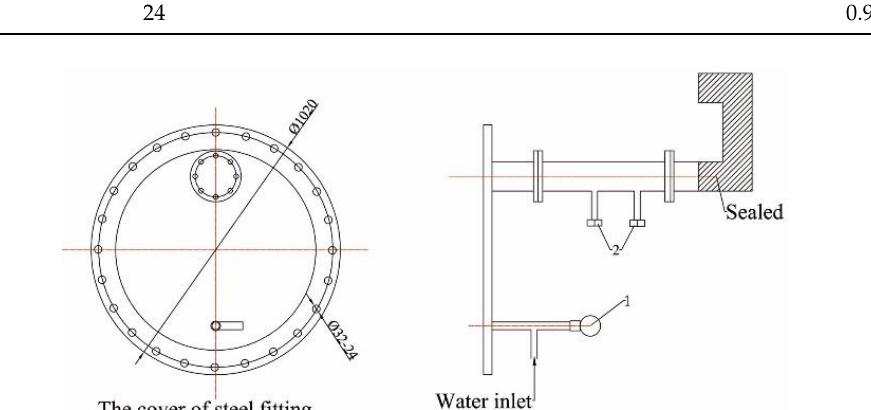
Figure 6. Load condition and load steps.